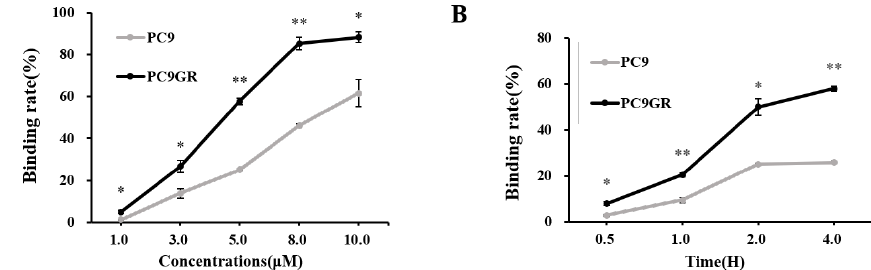
Figure 4. Cell binding rates of Cy3-ADH-1 in PC9GR and PC9. (A) The binding rates increased with the increase in Cy3-ADH-1 concentration at 2 h. (B) The binding rates increased with the increase in incubation time at 5.0 µ M. (* p < 0.05, ** p < 0.01).